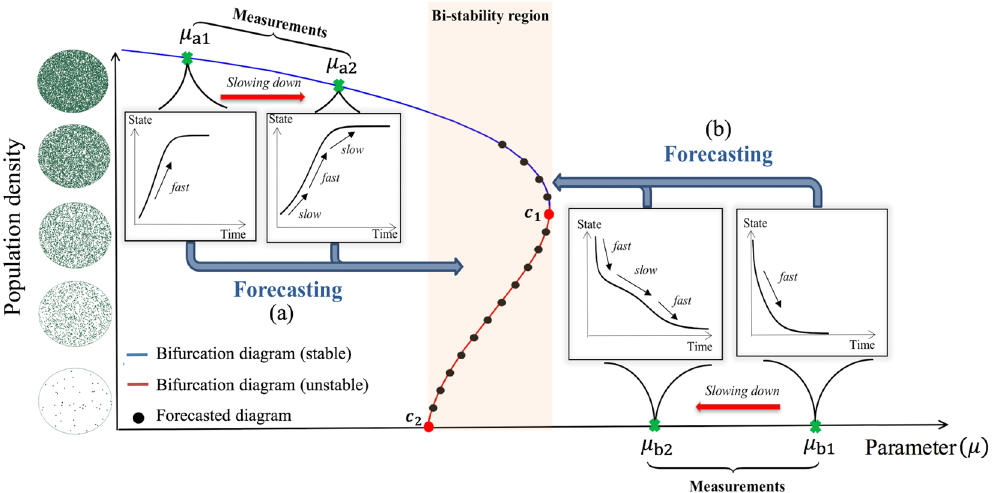
Figure 2. Schematic overview of the bifurcation forecasting method. Measurements from perturbations in pre- bifurcation conditions are employed to forecast the upcoming transition (black dots). As the system approaches a bifurcation, the rate of system’s recovery is decreased. At a fixed amplitude, the recovery rate decreases when the system approaches the bifurcation. At a fixed parameter, the smallest recovery rate corresponds to the amplitude which is closest to the actual bifurcation diagram. The future stability of the system is forecasted considering this change in the recovery rates. The system has two critical points (c 1 and c 2 ) which determine the boundaries of the bi-stability region. Cases ( a , b ) demonstrate a schematic of the forecasting procedure for the system operating at either side of the critical points, and are addressed in the experimental